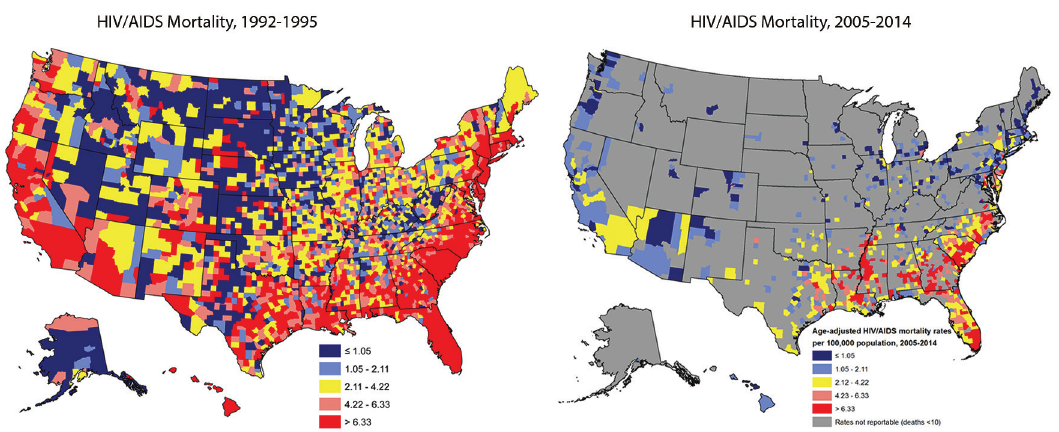
Fig ure 25. Age-adjusted HIV/AIDS Mortality Rates per 100,000 Population, United States, 1992-2014 (3,143 Coun - ties) Source: Singh GK, Azuine RE, Siahpush M. Widening Socioeconomic, Racial, and Geo graphic Disparities in HIV/AIDS Mortality in the United States, 1987-2011. Advances in Preventive Medicine. 2013. DOI: 10.1155/2013/657961. Updat- ed data derived from the US National Vital Statistics